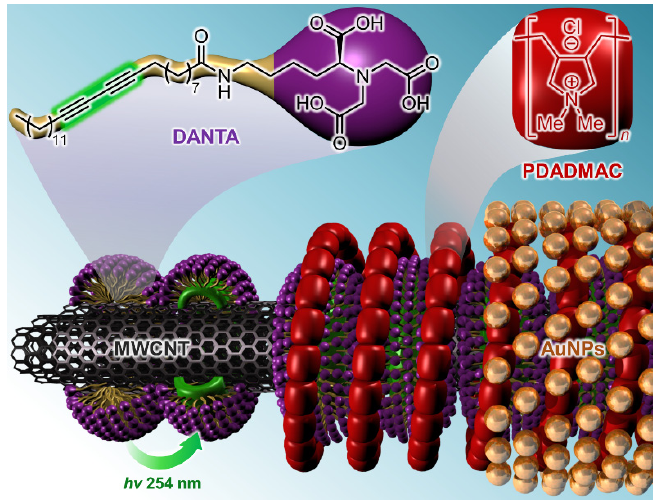
Figure 4. Illustration of the assembly of gold nanoparticles on a carbon nanotube using a layer-by- layer strategy.